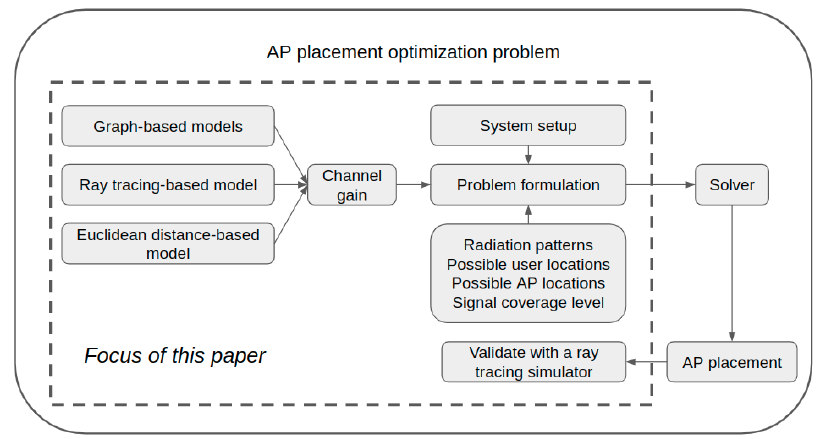
Figure 1. The access point (AP) placement optimization problem includes two parts: problem model- ing (the blocks within the dashed line) and solver development. This paper focuses on the problem modeling part. We discuss different setups for the distributed massive multiple-input multiple- output (D-mMIMO) system and different ways for modeling the environment. Four approaches for calculating the channel gain at each user location have been considered: a ray-tracing simulator (RTS)-based model and a Euclidean distance-based model, both of which are from the literature, and two graph-based models which are proposed in this